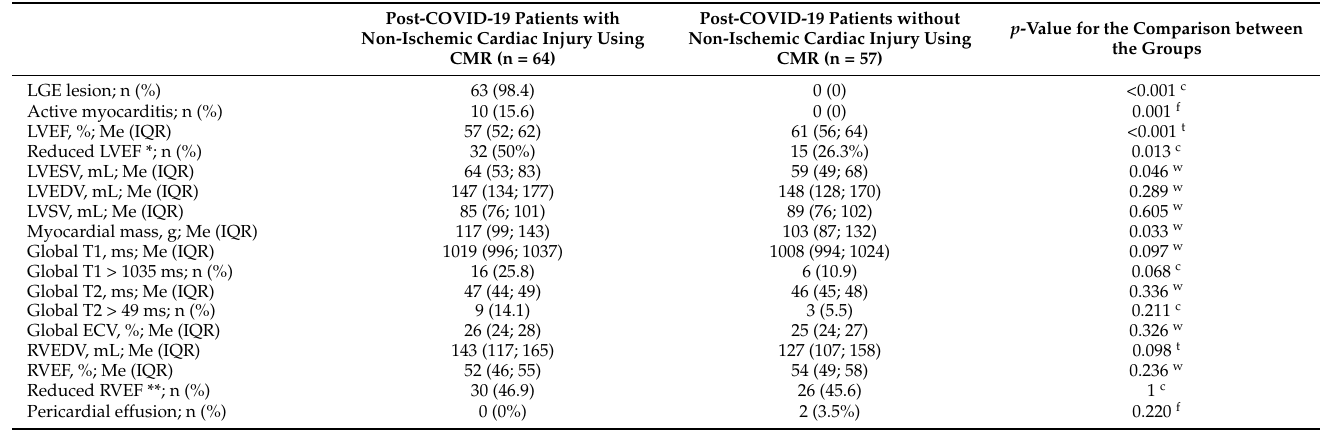
Table 4. Comparison of CMR characteristics between post-COVID-19 patients with and without non-ischemic cardiac injury. Non-ischemic cardiac injury indicates the presence of LGE and/or CMR features of active